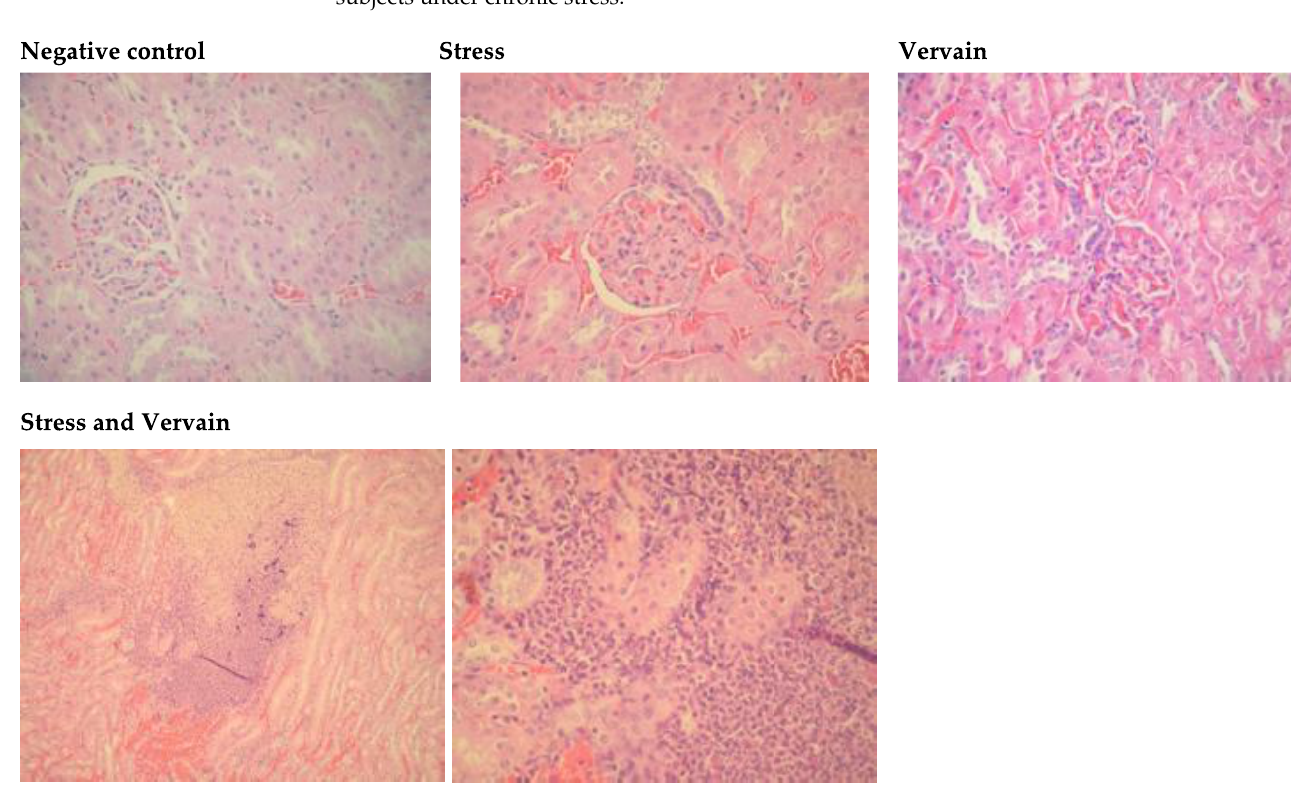
Figure 9. Kidney histology under different treatment conditions, H.E. staining, 400×; bottom line — stress and vervain condition — At = 100× and 400×, respectively. The first figure represents normal renal structure of animals maintained under normal conditions. The application of stress stimuli to the animals affected the kidney histology, with hemorrhages and altered renal structure observed. The herbal extract was unable to restore normal renal morphology in subjects under chronic stress, and the renal cortex and glomeruli were significantly affected by co-exposure to stress and herbal